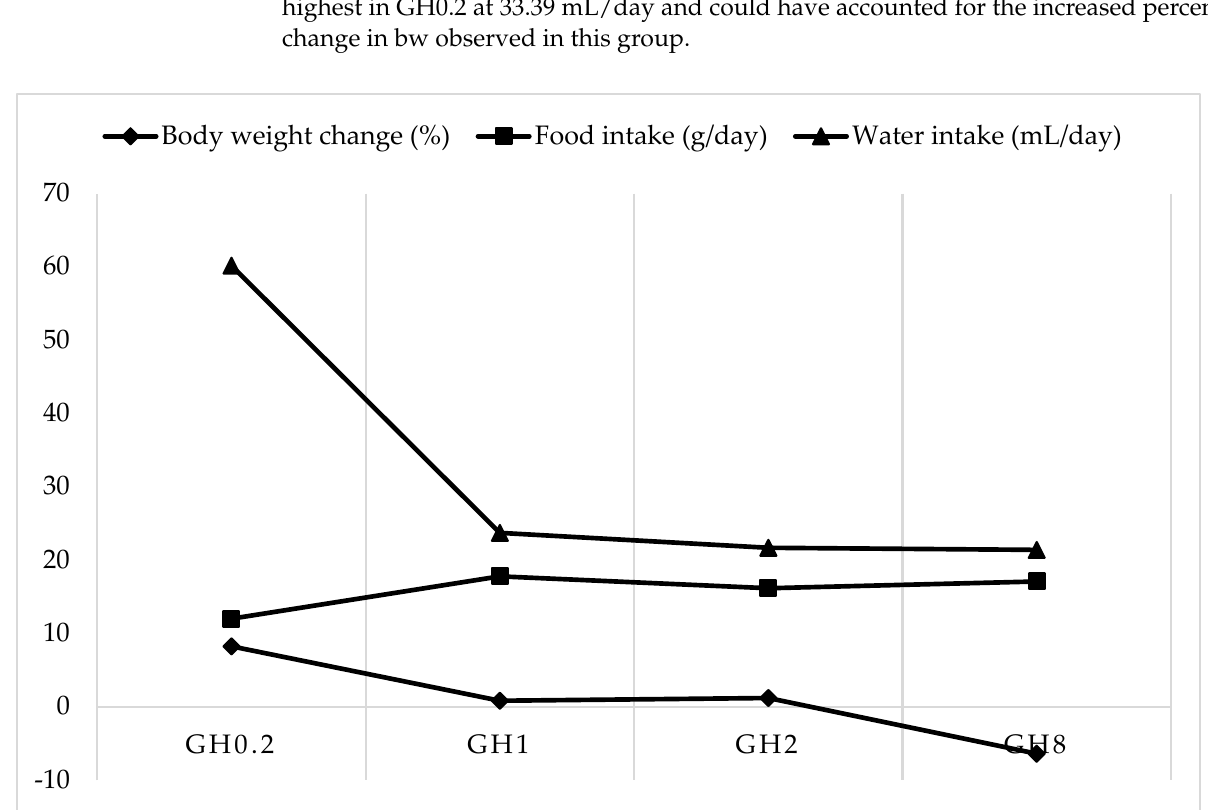
Figure 4. Comparison of the body weight (bw) change in relation to the food and water intake among groups. GH0.2 (0.2 g GH/kg bw/day); GH1 (1 g GH/kg bw/day); GH2 (2 g GH/kg bw/day); GH8 (8 g GH/kg bw/day).